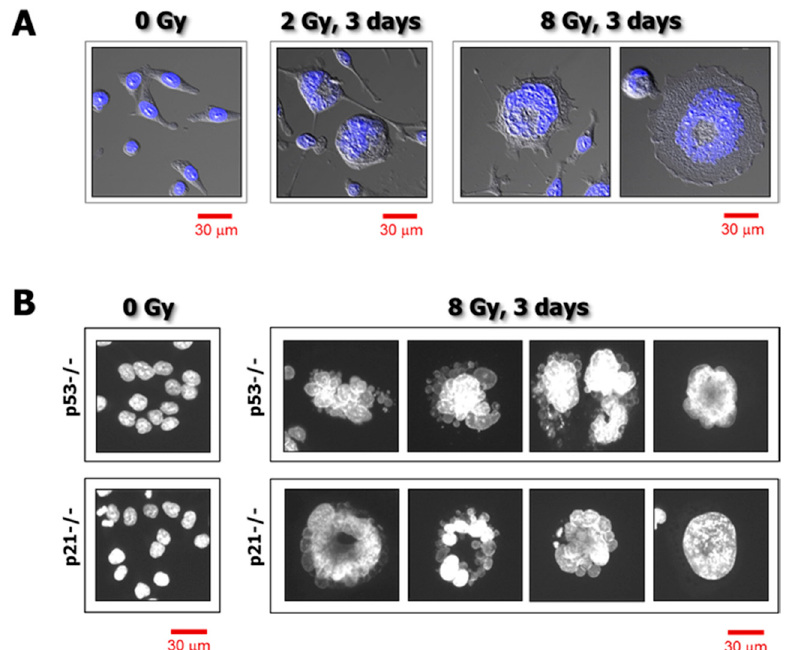
Figure 1. ( A ) Confocal microscopy images showing nuclear morphology of p21 knockout HCT116 cells before and 3 days after exposure to γ radiation. Nuclear content (DAPI staining) is shown in blue. ( B ) Fluorescence images showing the nuclear morphology of p53 knockout (p53 − / − ) and p21 knockout (p21 − / − ) HCT116 cells before and 3 days after irradiation. Nuclear content (DAPI) is shown in white. Data obtained from Mirzayans et al. [3].